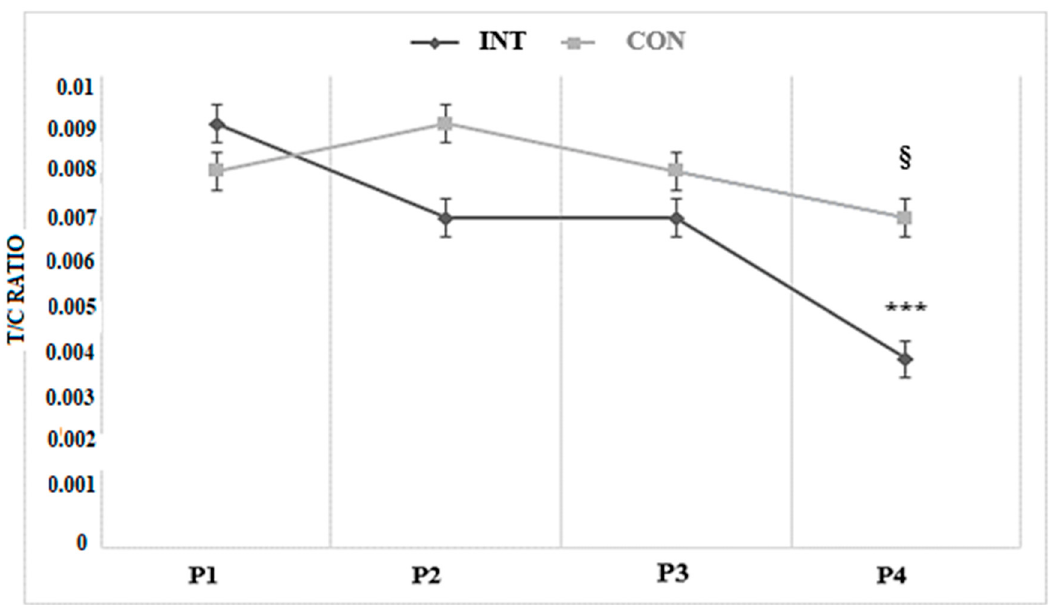
Figure 2. Variation of testosterone / cortisol ratio during the experimental period for the intervention and active control groups. Legend. INT: intervention group; CONT: active control group; T / C RATIO: testosterone / cortisol ratio; P1: blood samples before the beginning of the experimental period; P2: after 4 weeks; P3: after 8 weeks; P4: after 12 weeks; ***: significant di ff erences between blood sampling at P4 p < 0.001; §: significant di ff erences between groups at P4 p < 0.01.